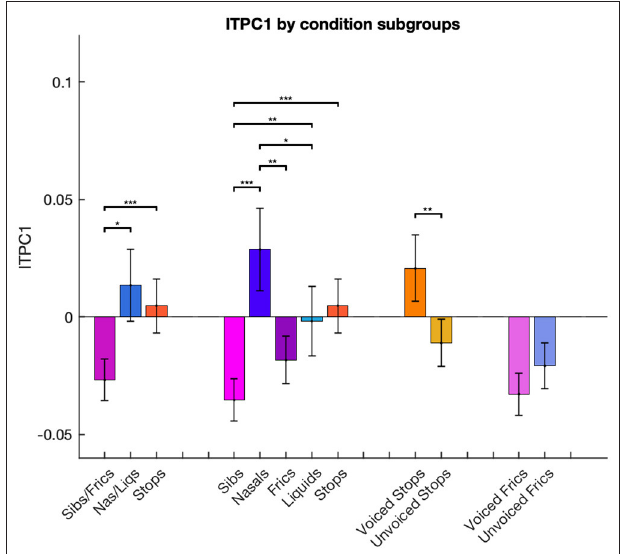
FIGURE 4 | Differences in ITPC1 calculated for conditions combined in different groups. ITPC1 values in each condition are averaged across multiple phonemic subgroups: stops, fricatives/sibilants and nasals/liquids; stops, fricatives, sibilants, nasals and liquids; voiced and unvoiced stop consonants; voiced and unvoiced fricative/sibilant consonants. Error bars represent standard error of the mean. *** p < 0.001, ** p < 0.01, and * p < 0.05, Bonferroni-corrected.